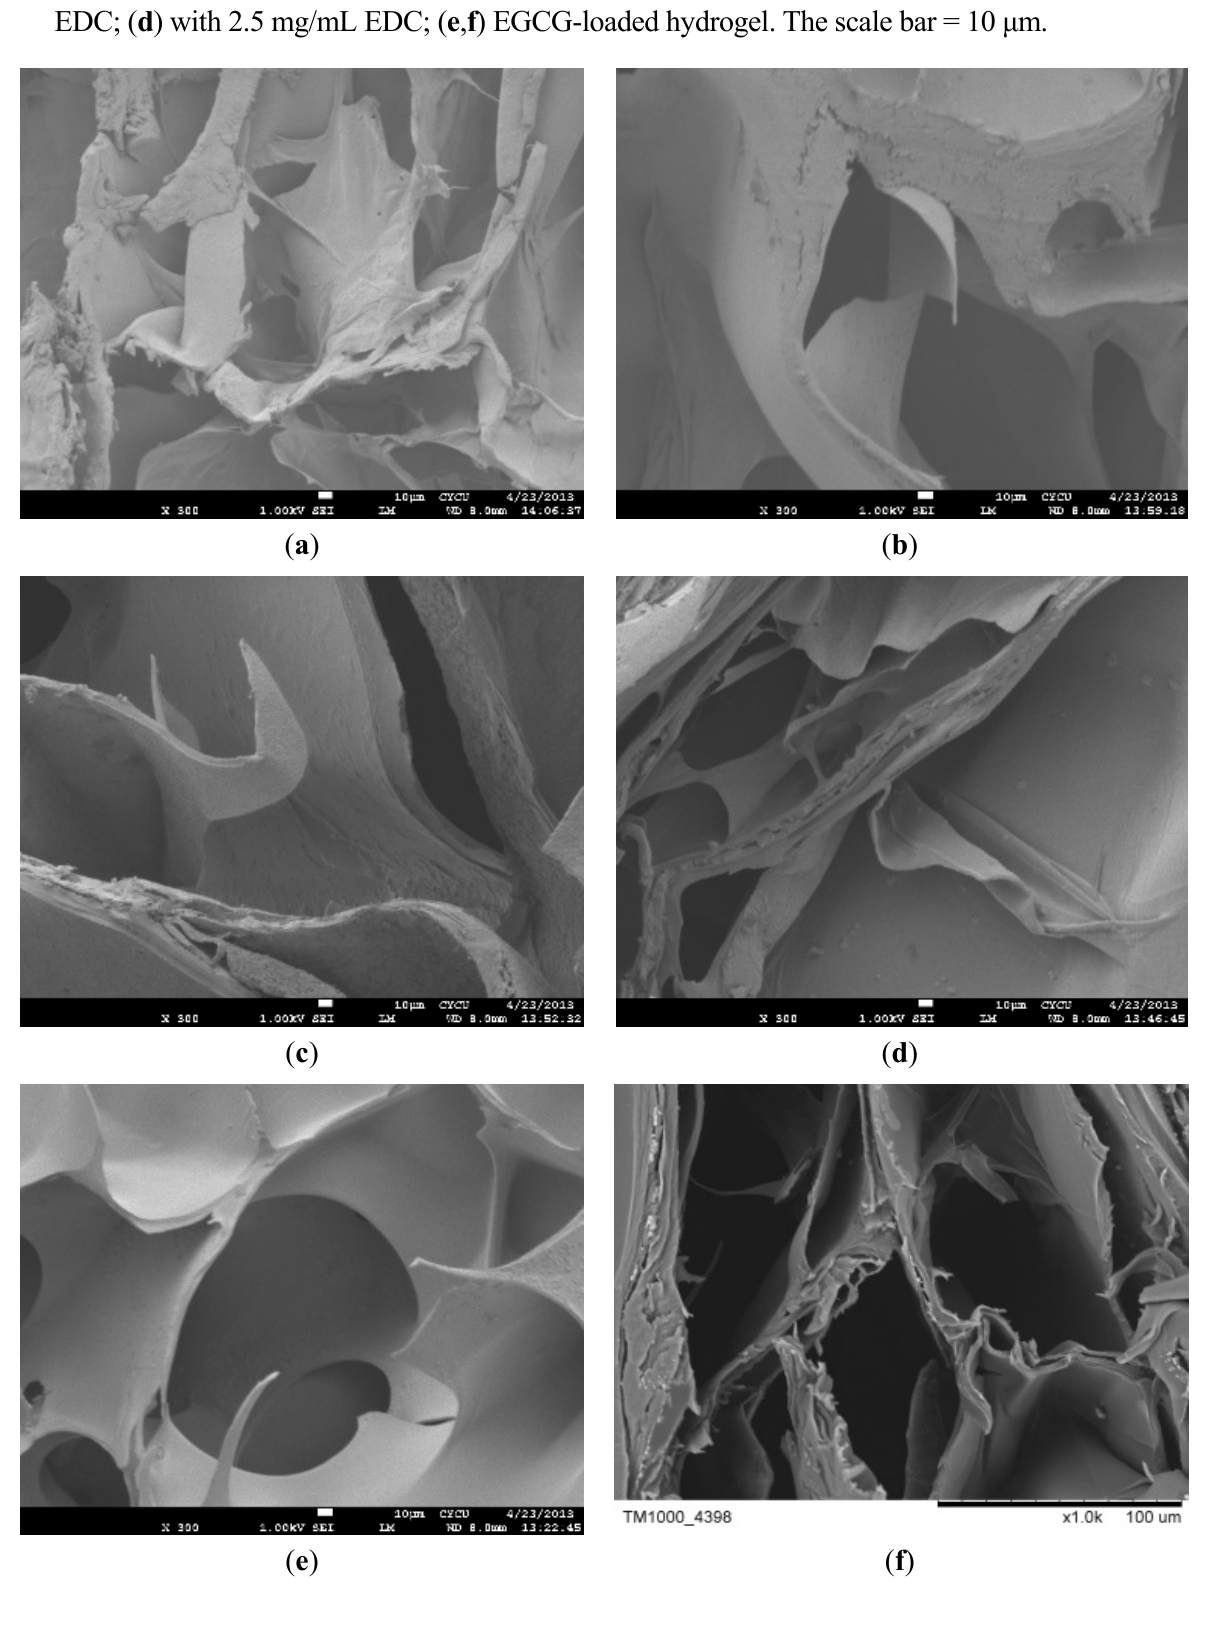
Figure 7. Scanning electron micrograph of the cross-section of freeze-dried hydrogel at 300× for ( a – e ) and 1000× for ( f ): ( a ) uncrosslinked; ( b ) with 0.75 mg/mL EDC; ( c ) with 1.3 mg/mL EDC; ( d ) with 2.5 mg/mL EDC; ( e , f ) EGCG-loaded hydrogel. The scale bar = 10 μ